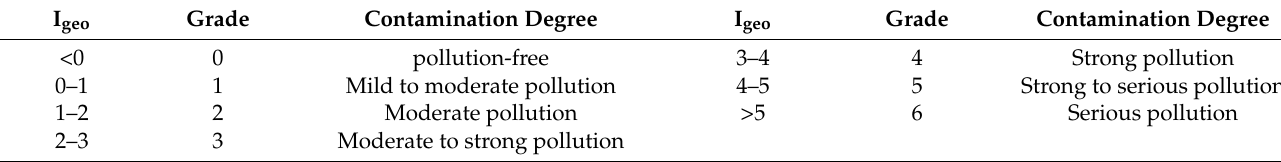
Table 1. Classification of the pollution degree of the index of geo-accumulation (I geo